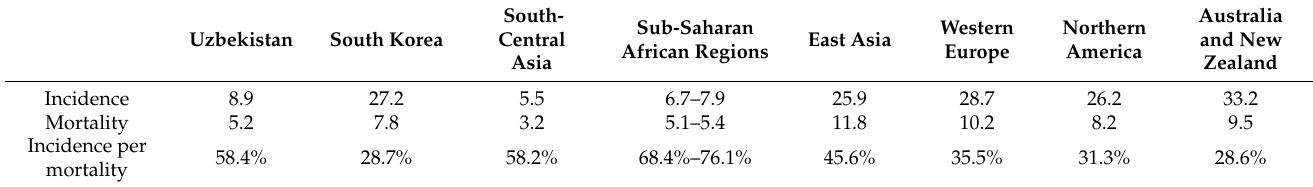
Table 2. Brief global statistics of colorectal cancer, including Uzbekistan and South